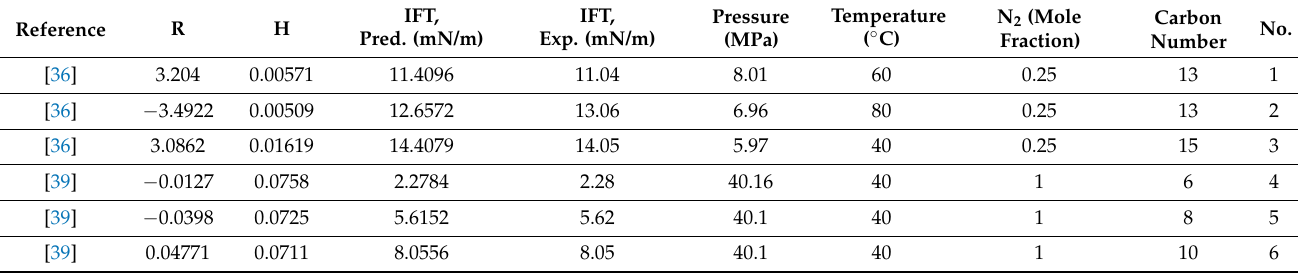
Figure 12. Identification of RBF model usability scope and doubtful data using William’s plot. Table 3. Detected suspected data or outliers for the RBF model according to the leverage